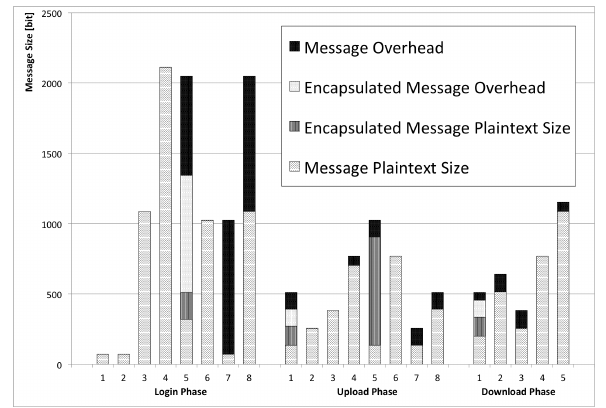
Figure 15. Messages encryption size